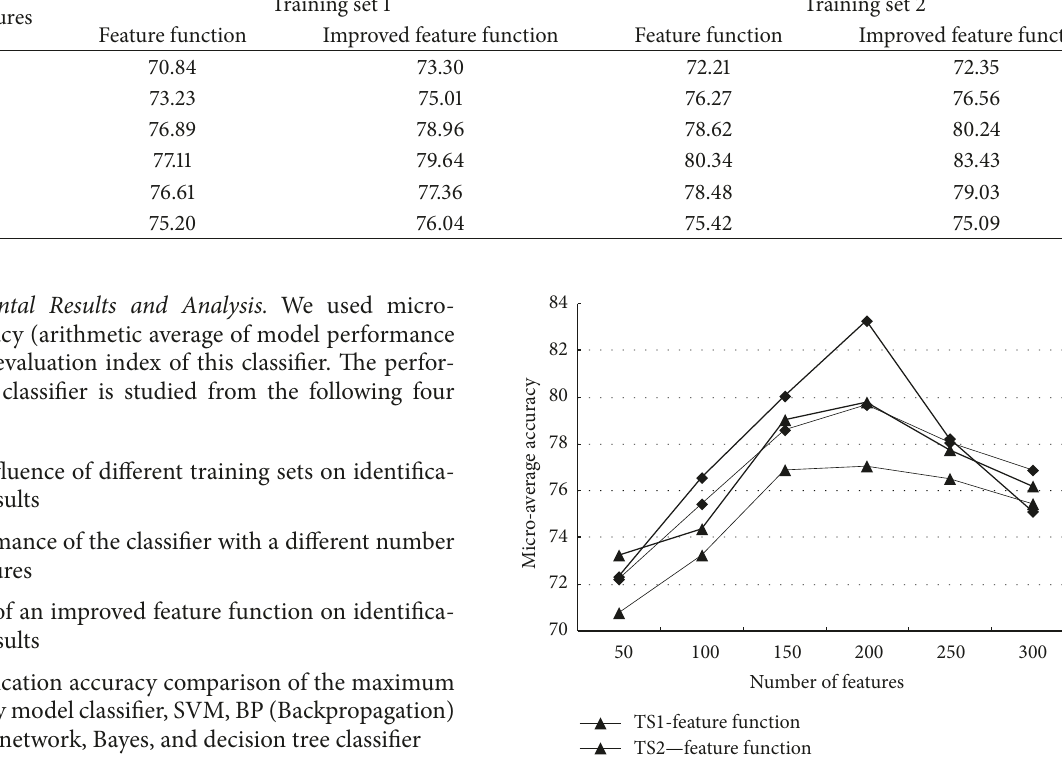
After calculation, the AUC value of the maximum entropy model classifier is 0.7954, which can be considered as